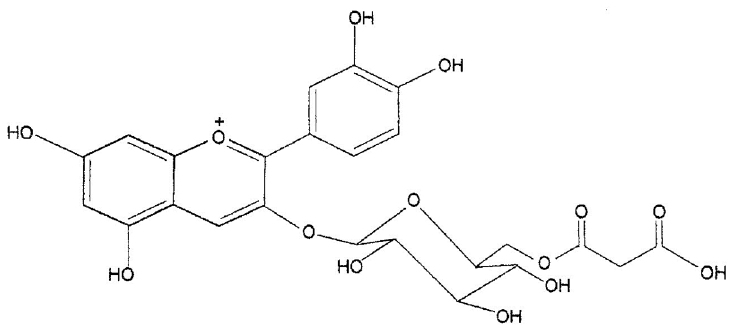
Figure 3. Chemical structure of pigment II: cyanidin-3-(6 ″ -malonyl)- β -glucoside). Reprinted under CC BY-NC 4.0 from Maccarone et al., [41].